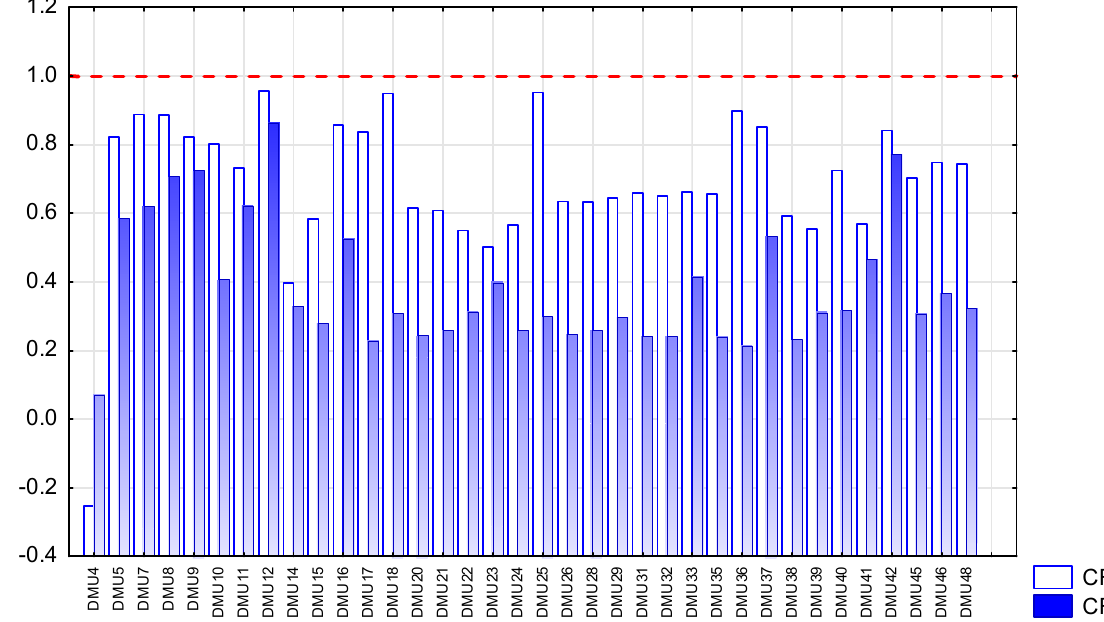
Figure 4. Comparison of current and target values of CR. Legend: CR c —current Cost ratio, CR t —target Cost ratio.